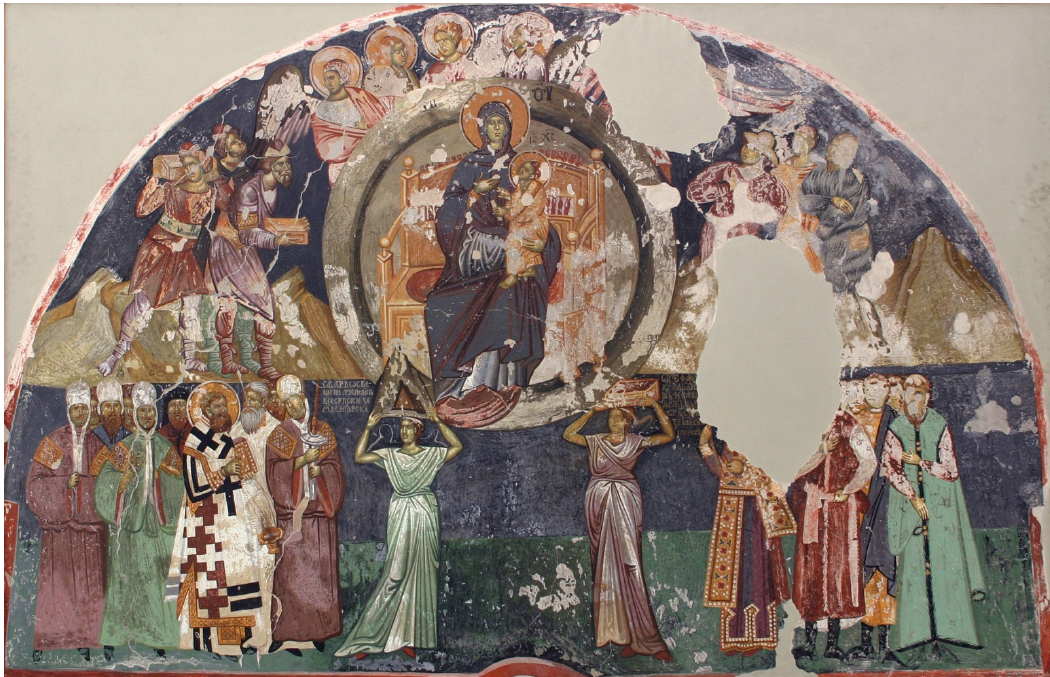
Figure 2. King Milutin leading ceremonial procession within the scene of the Christmas Hymn (right), fresco, 1309–1316. Ascension Church of the Ži č a Monastery, south side of the lunette above the entrance. Courtesy Gallery of Frescoes, Belgrade.